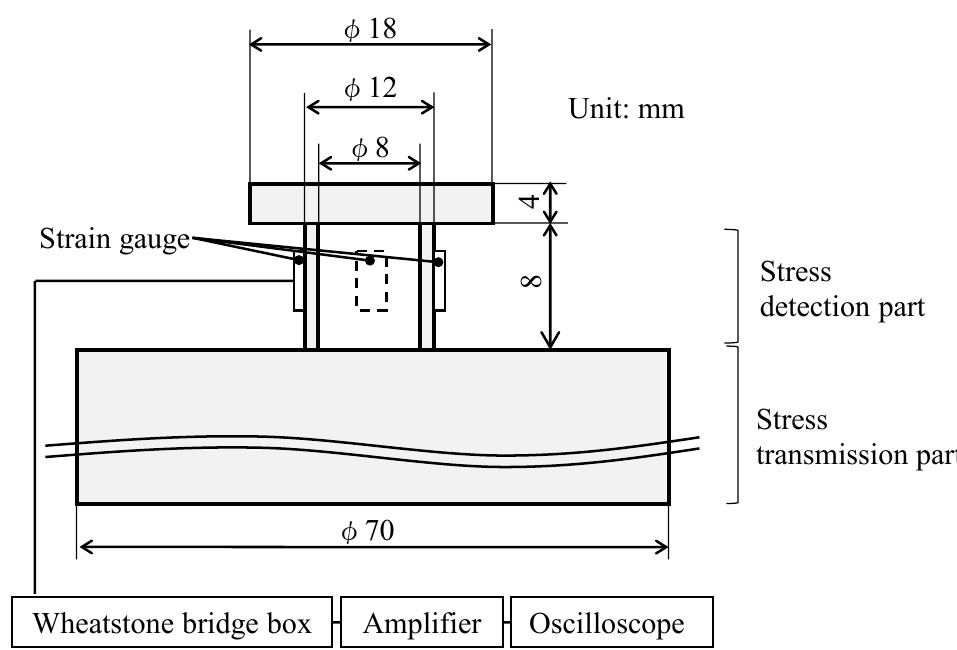
Figure 5. Schematic view of universal rate range load cell.